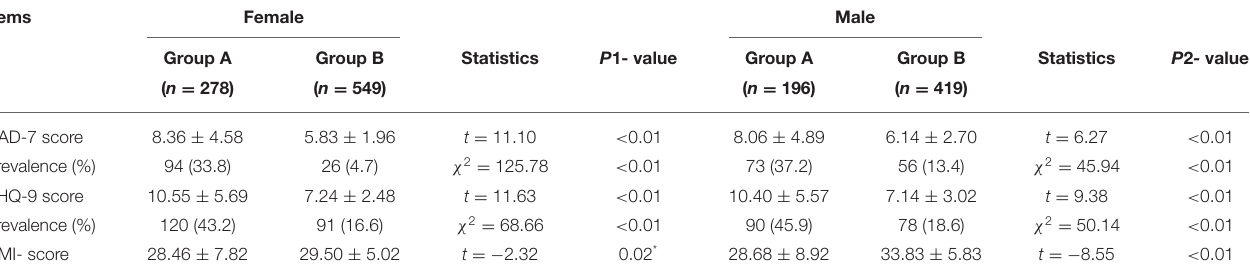
TABLE 5 | Subject’s psychological health and quality of couple